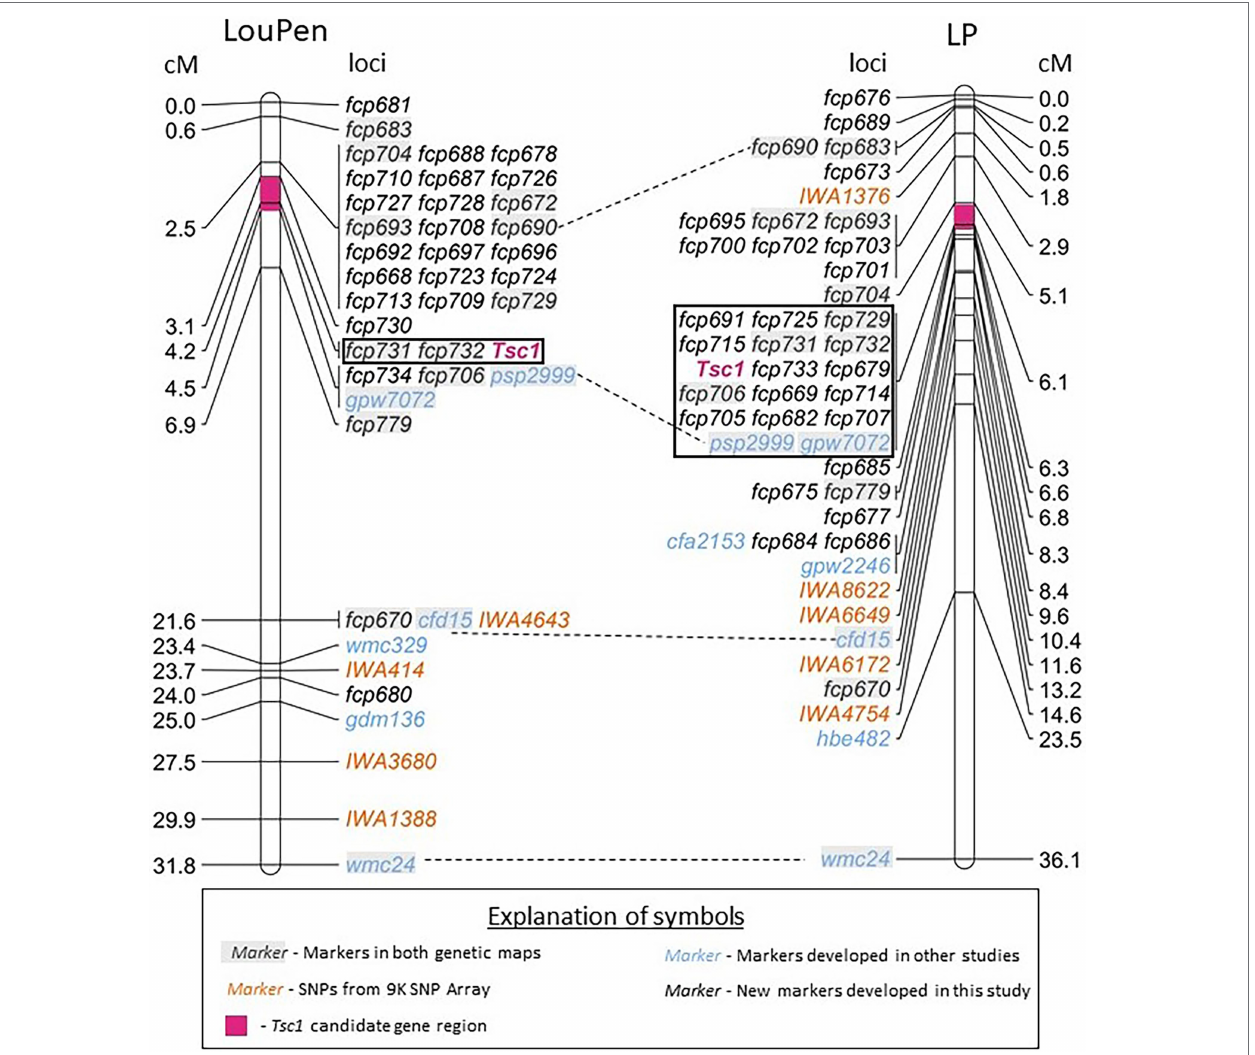
FIGURE 2 | Saturation maps of the Tsc1 region developed in Louise × Penawawa (LouPen) and LMPG-6 × PI 626573 (LP) populations. The LouPen genetic map is on the left and the LP genetic map is on the right. Loci mapped are listed on the right of the LouPen genetic map and the left of the LP genetic map. Opposite the loci, the genetic distances are displayed in centiMorgans (cM). Markers in orange are SNP markers from the wheat 9 K iSelect Assay BeadChip. Markers in black are simple sequence repeat (SSR) markers designed in this study. Blue markers were designed in other studies. Dashed lines connect markers mapped in both populations. The black outlined rectangle indicates the loci cosegregating with Tsc1 . The pink shaded portion of the chromosome represents the candidate gene region in each